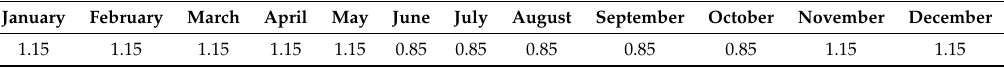
Table 1. Monthly ET p correction